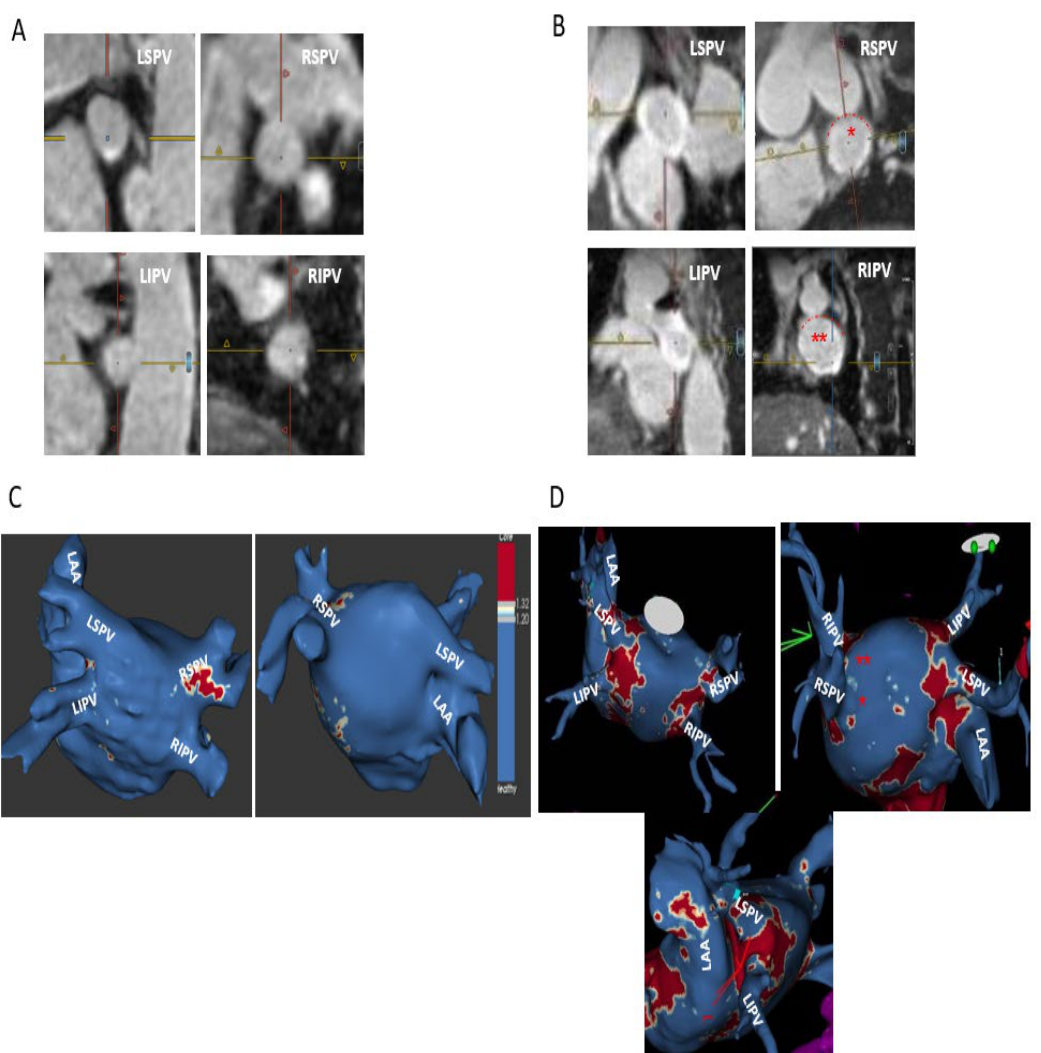
Figure 3. A typical patient with cryoballoon-induced partial incomplete circumferential fibrosis in both right PVs. Shown are pre-ablation ( A ) and post-ablation ( B ) cross-sectional short-axis views of the four PVs revealing minimal PV ostial fibrosis at baseline, while at post AF ablation, there is a complete circumferential fibrosis around both left PVs and partial incomplete circumferential fibrosis around both right PVs with major gaps in the roof and anterior segments of both veins (red dotted lines). ( C , D ) Corresponding ADAS 3D LGE model images pre ( C ) and post ( D ) cryoballoon AF ablation, showing minimal fibrosis at baseline ( C ). Post-ablation MRI ( D ) reveals a complete circumferential fibrosis around both left PVs (including the carinal view) and partial circumferential fibrosis of both right PVs due to major gaps in the anterior and roof segments of both RSPV( ＊ ) and RIPV ( ＊＊ ), corresponding and matching with the gaps seen on the “raw data” short-axis views. Post-ablation fibrotic areas on ADAS are colored red. Notably, Figures 1 and 3 both describe the same patient.